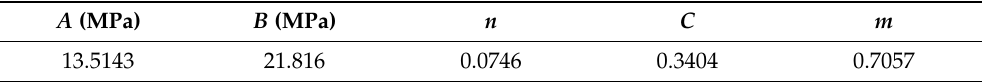
Table 2. Parameter values of the Johnson–Cook flow law for a medium carbon steel. A